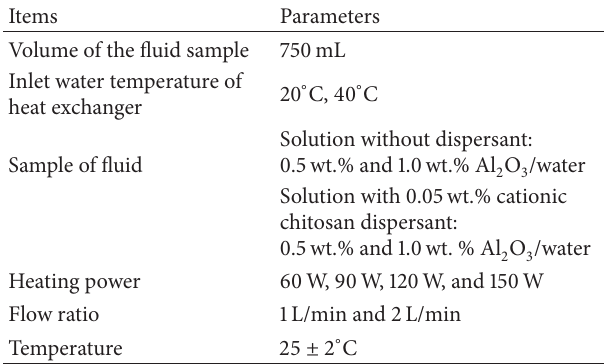
Table 1: Parameters in heat exchange